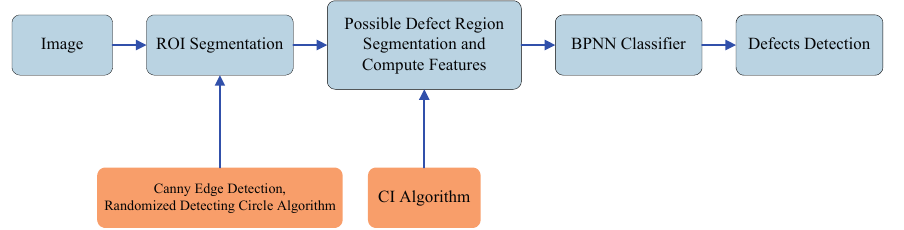
Figure 12. Segmentation and classification